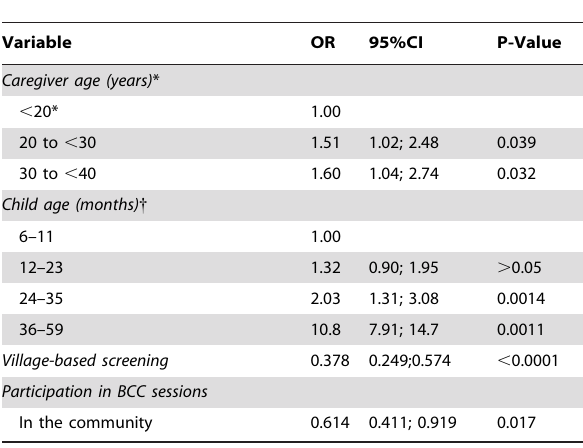
Table 4. Factors associated with participation in